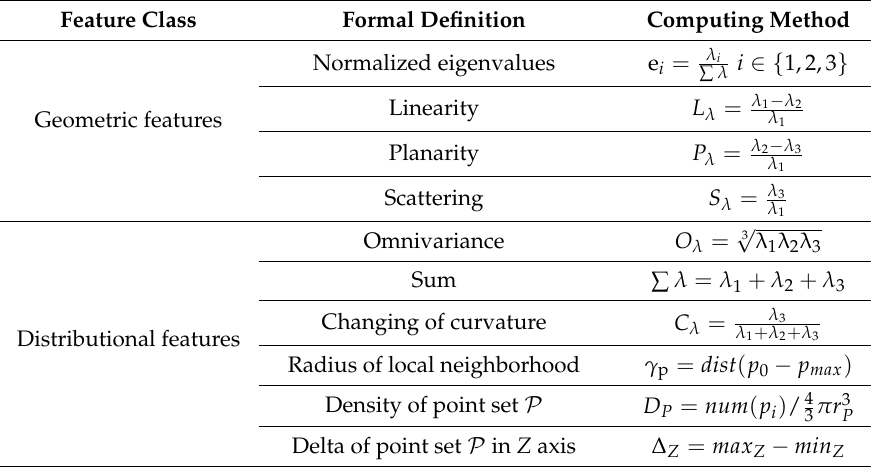
Table 2. A partial list of geometric features and distributional